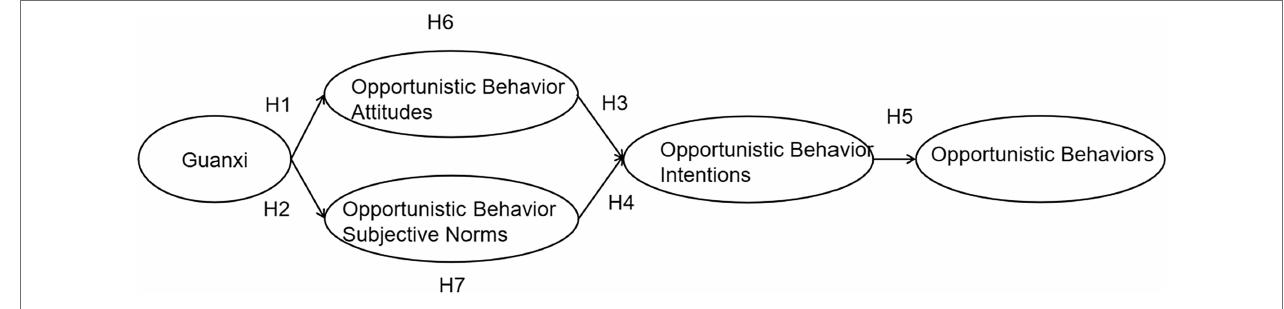
FIGURE 1 | Theoretical framework of the